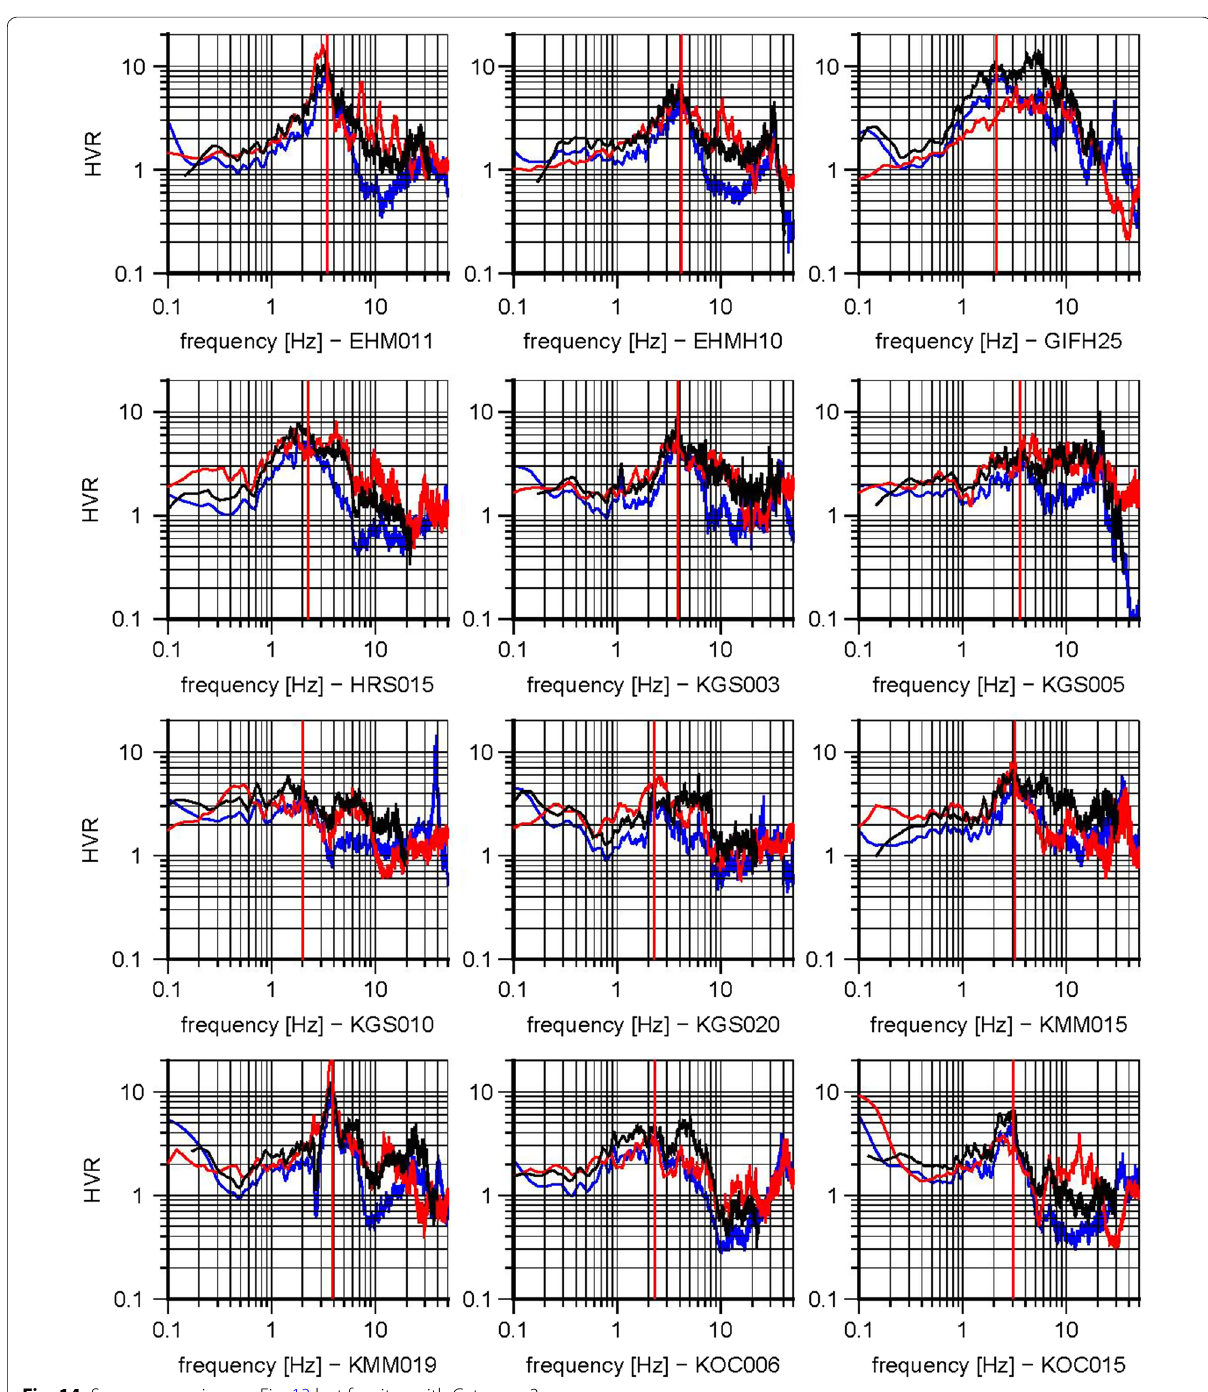
Fig. 14 Same comparison as Fig. 13 but for sites with Category